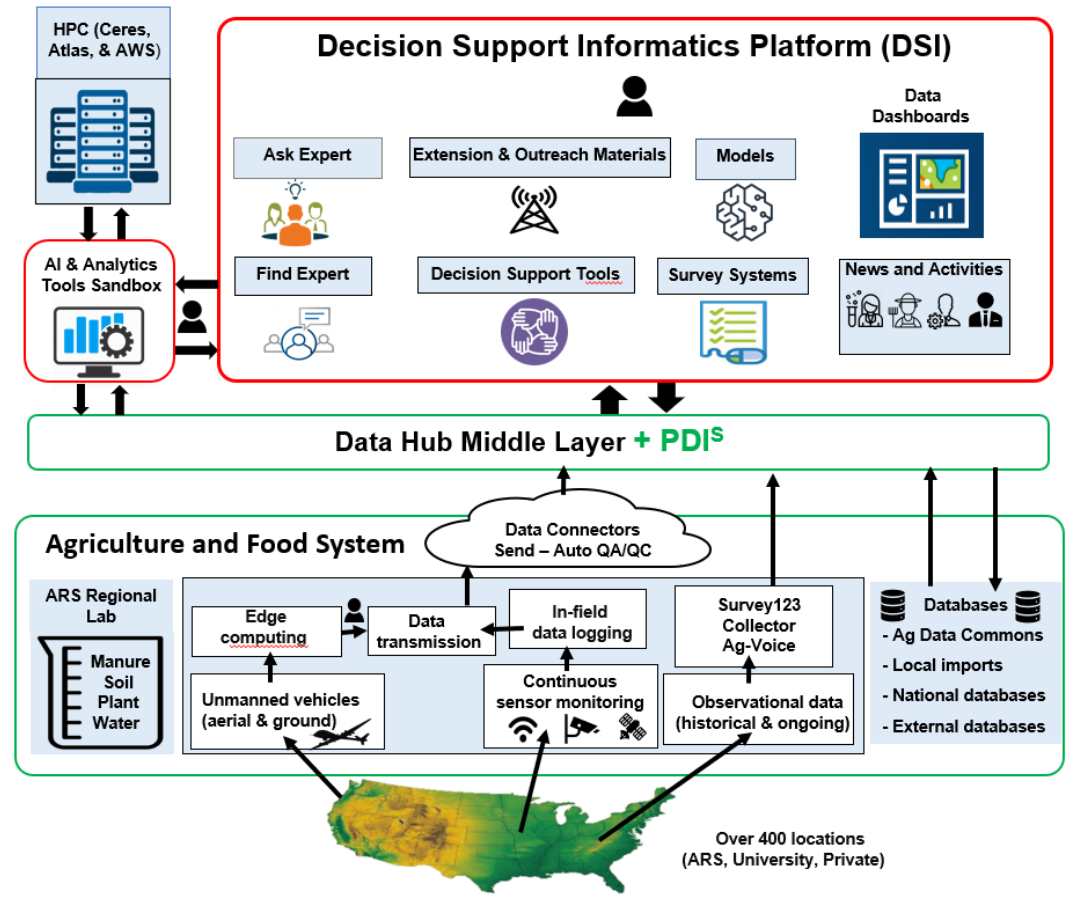
Figure 3. The Decision Support Informatics platform approach to Knowledge Management.